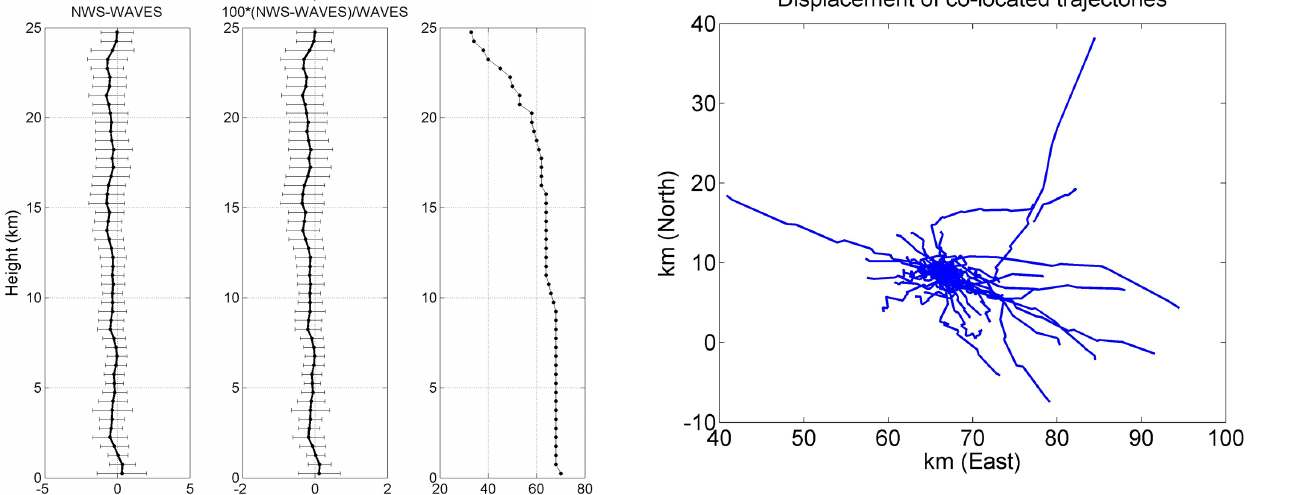
Figure 2. The displacement of collocated trajectories is given by the difference of positions for two collocated instruments at the same al- titude. X axis is distance along parallels and Y axis along meridians. Distance range is